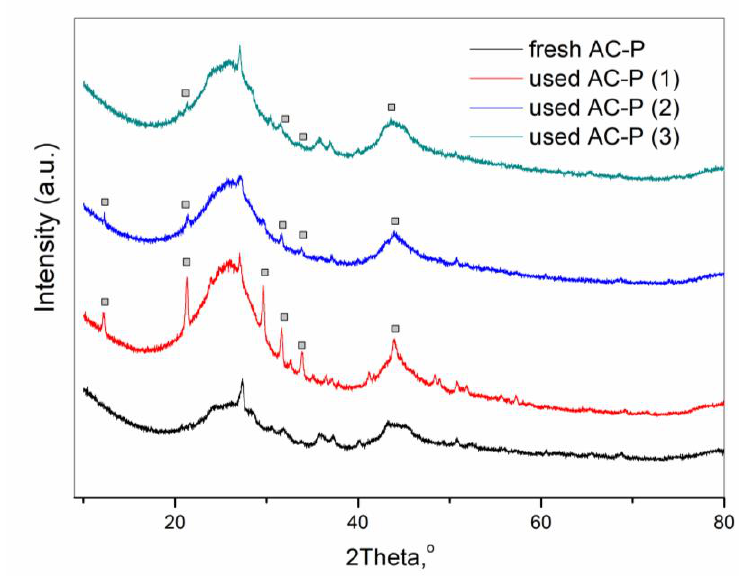
Figure 7. The XRD spectra of activated carbon (fresh and after use in the deSO x and deNO x ad- sorber): fresh AC-P, used AC-P (1), used AC-P (2) and used AC-P (3). fresh AC-P, used AC-P (1), used AC-P (2) and used AC-P